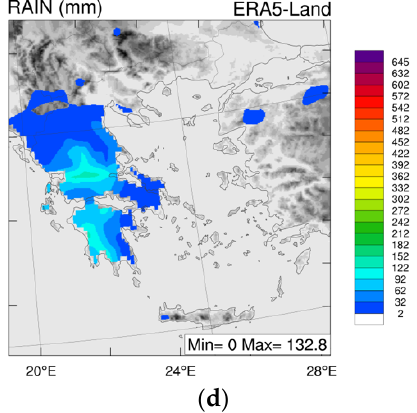
Figure 17. Spatial distribution of precipitation accumulated from 18 to 24 UTC on 18 September 2022. In ( a ), the accumulated precipitation as predicted from the FULL simulations is depicted. In ( b ), the accumulated precipitation as predicted from the GTS simulations is depicted. In ( c ) and ( d ), the accumulated precipitation from the NO simulation and from the reanalysis data ERA5-Land is shown, respectively.